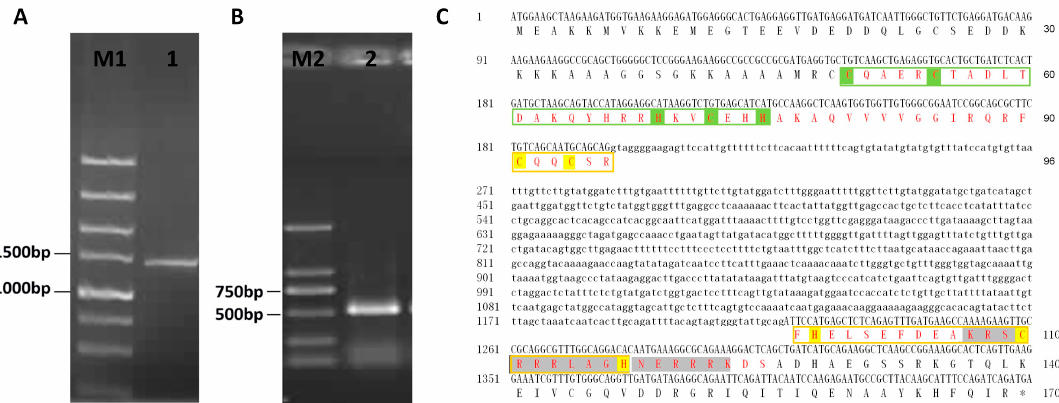
Figure 1. Cloning and sequence analysis of VpSBP11 from V . pesudoreticulata . ( A ) PCR amplification of the full length VpSBP11 DNA and ( B ) complementary DNA (cDNA) from Vitis pseudoreticulata . DNA marker DL5000; M2: DNA marker DL2000; 1: VpSBP11 PCR product from DNA; 2: VpSBP11 PCR M1: DNA marker DL5000 ; M2: DNA marker DL2000 ; 1: VpSBP11 PCR product from DNA; 2: product from cDNA; ( C ) The full length DNA, cDNA nucleotide sequence, and deduced amino acid VpSBP11 PCR product from cDNA; ( C ) The full length DNA, cDNA nucleotide sequence, and sequence of VpSBP11 from V . pesudoreticulata . The Squamosa promoter binding protein (SBP) domain is deduced amino acid sequence of VpSBP11 from V . pesudoreticulata . The Squamosa promoter binding shown in red and the two zinc-binding sites of the C2HCH type (zinc finger 1 and zinc finger 2) are location signal are shaded in dark